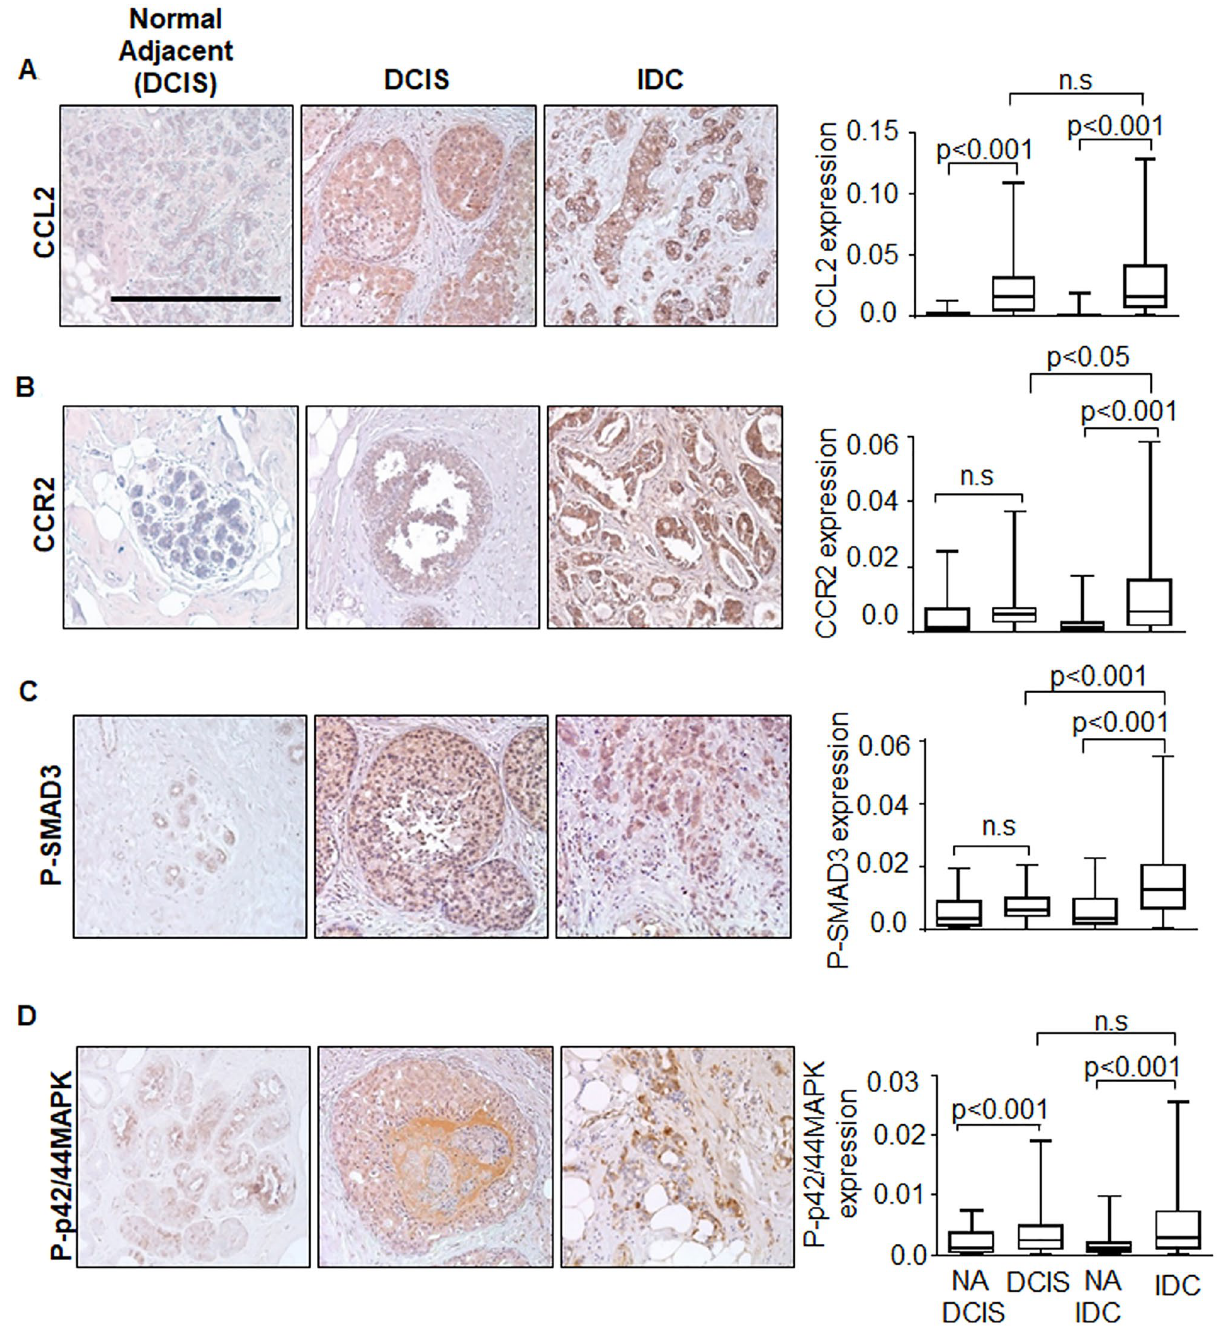
Figure 1. Expression of CCL2/CCR2 related signaling proteins are elevated in DCIS and further upregulated in IDC patient tissues. TMAs containing DCIS (n = 72), IDC (n = 74) or normal adjacent breast tissues to DCIS (NA DCIS) (n = 25) or to IDC (NA IDC) (n = 61) were immunostained with antibodies to: ( A ) CCL2, ( B ) CCR2, ( C ) phospho-SMAD3 or ( D ) phospho-p42/44MAPK. Scale bar = 200 microns. Immunostaining was quantified by Image J. Whisker box plots are shown. Whiskers indicate min and max values. Box indicates upper and lower quartile range. Line indicates median. Statistical analysis for DCIS vs. IDC was performed using Mann– Whitney–Wilcoxon Test. Statistical analyses for NA DCIS vs. DCIS and NA IDC vs. IDC were performed using Wilcoxon Signed Rank Test. Statistical significance analysis was determined by p < 0.05. ns not significant. Scale bar = 200